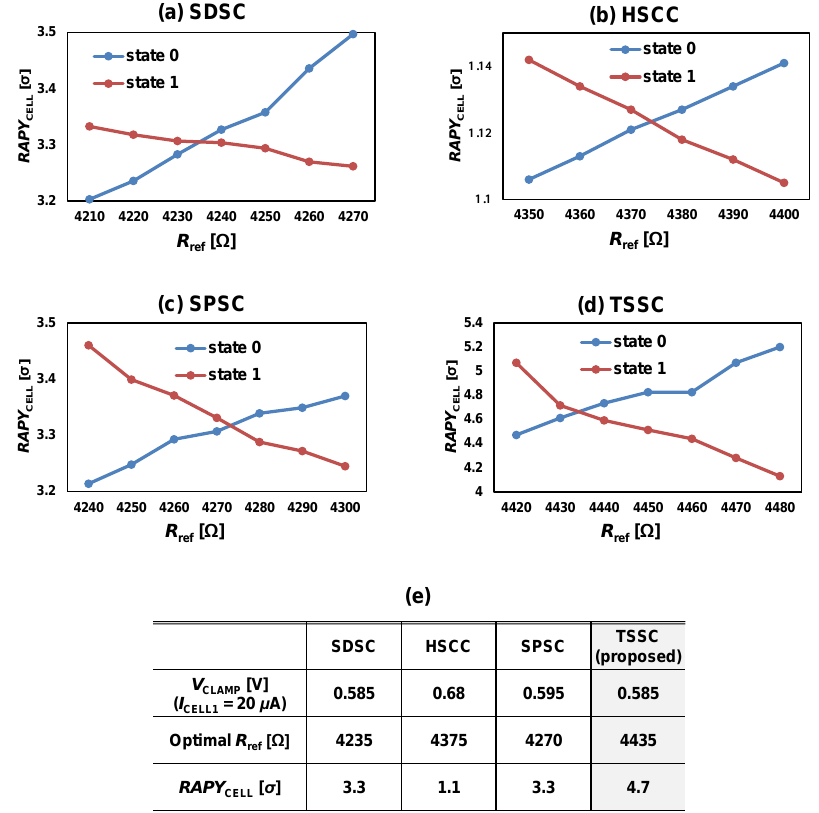
Figure 5. RAPY CELL0 and RAPY CELL1 of ( a ) SDSC; ( b ) HSCC; ( c ) SPSC; and ( d ) TSSC with respect to R ref . ( e ) Optimal R ref and RAPY CELL of SDSC, HSSC, SPSC, and TSSC.